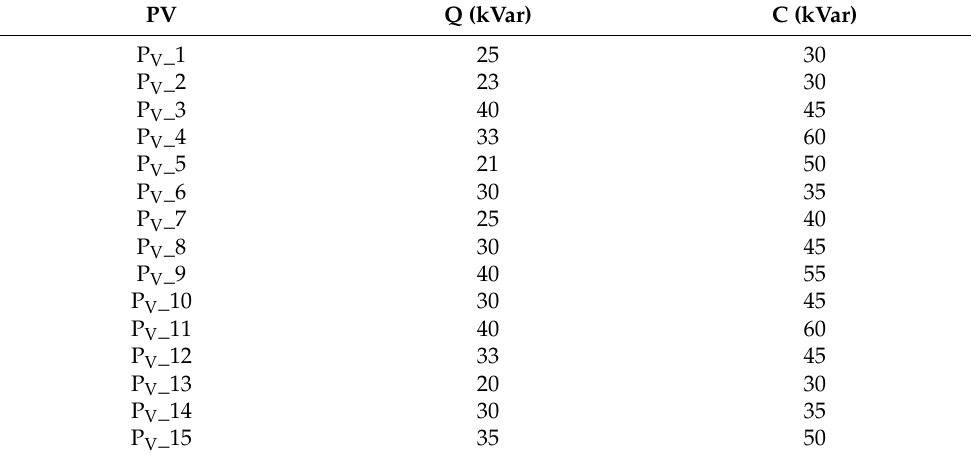
Table 1. Parameters of distributed